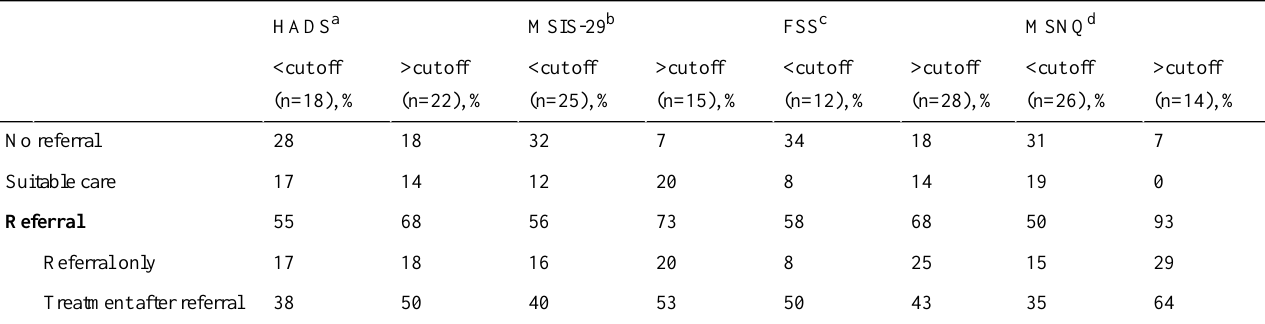
Table 1. Percentage referred and treated MS patients with low and high levels of distress